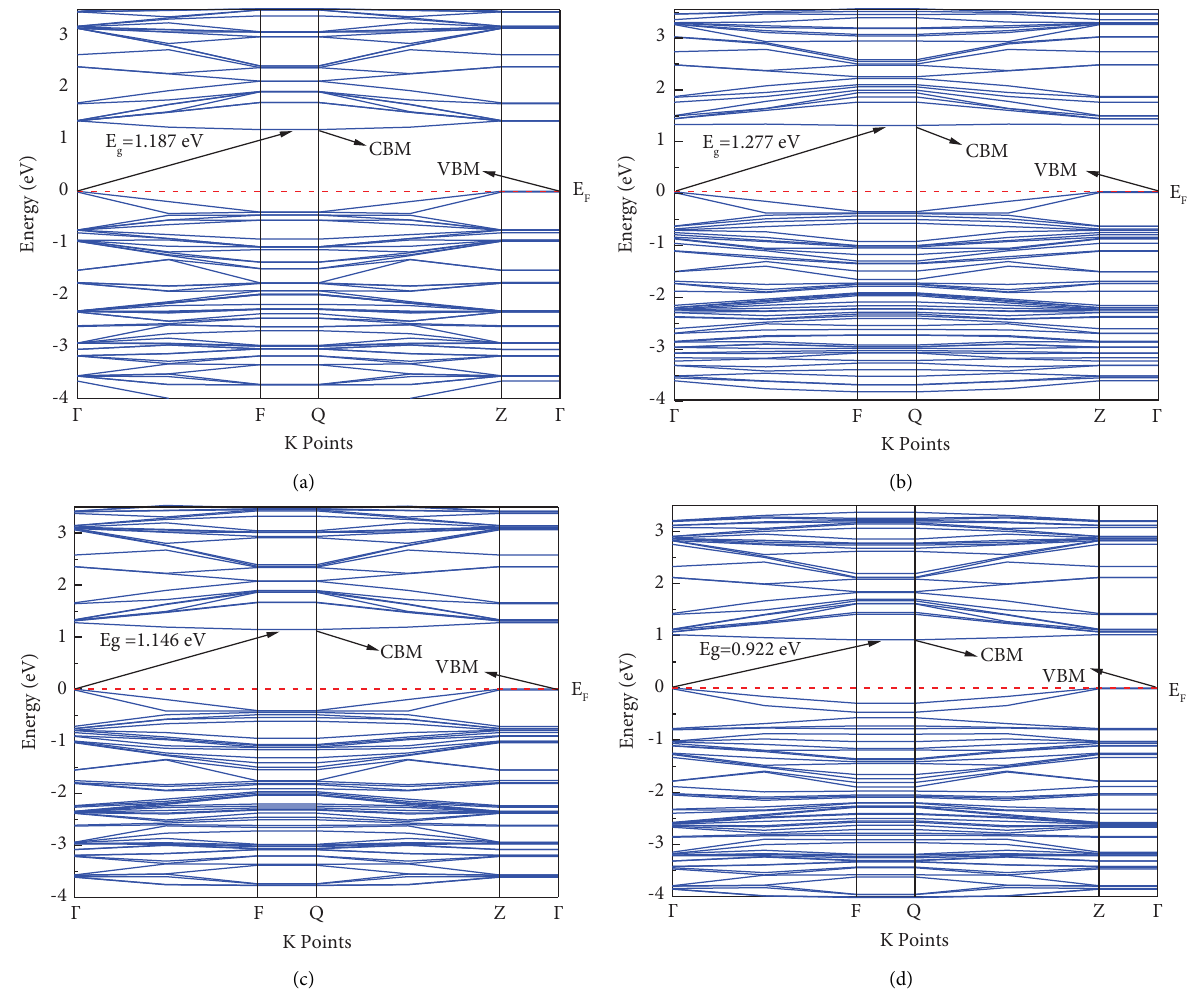
Figure 2: Band structures of pristine and single-doped ZrS 2 . (a) ZrS 2 . (b) O-doped ZrS 2 . (c) Se-doped ZrS 2. (d) Te-doped ZrS